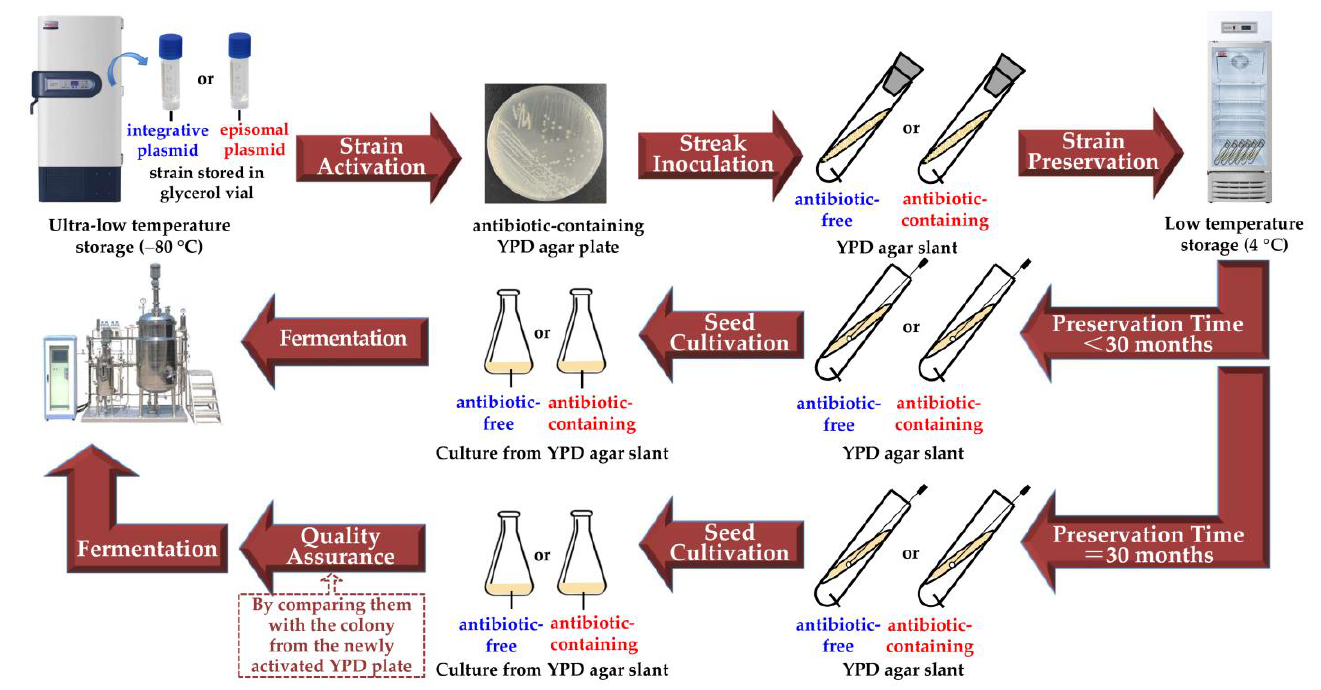
Figure 5. Flowchart for the preservation and fermentation of recombinant